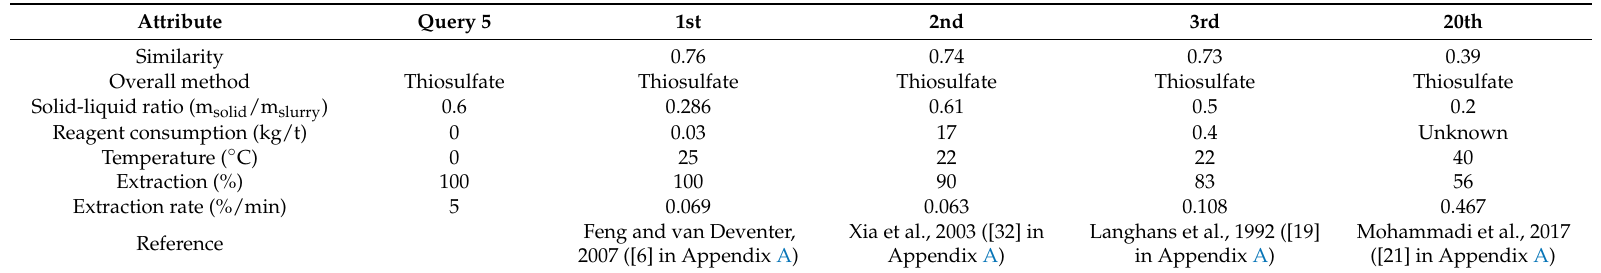
Table 9. Query 5 (Industrially Attractive) with the three most similar articles retrieved from the case